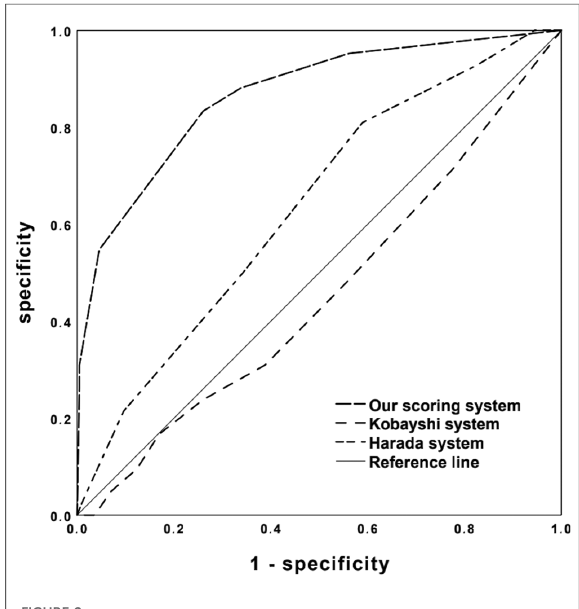
FIGURE 2 ROC curves of the novel simple scoring model, Kobayashi and Harada scoring systems in predicting CALs